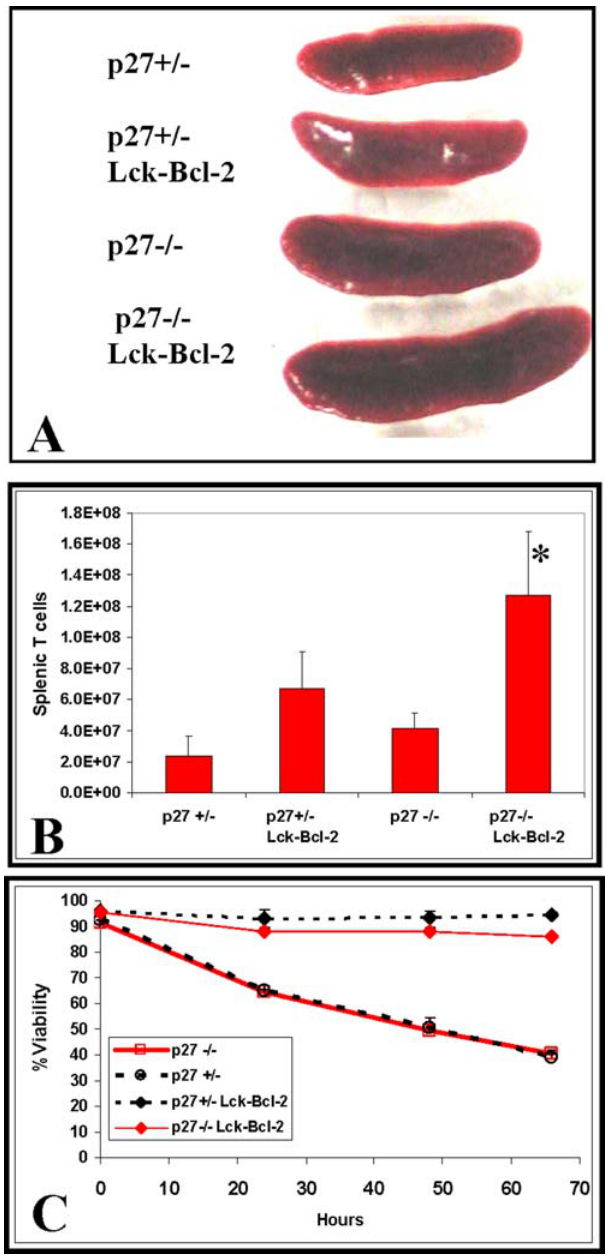
Figure 1. Lymphoid hyperplasia in p27 2 / 2 Lck-Bcl-2 mice. Spleens were dissected and T cells isolated from p27 2 / 2 Lck-Bcl-2 transgenic mice and analyzed for viability and total splenic T cells as described in the Materials and Methods. Control groups included p27 2 / 2 , p27 + / 2 , and p27 + / 2 Lck-Bcl-2 mice. A ) Representative images of spleens from mice of the indicated genotypes. B ) Total splenic T cells were determined by staining with an anti-CD3 antibody as described in the Materials and Methods. The Mean 6 SD of at least three mice is shown for the genotypes indicated. * P value , 0.01 compared to all three other groups. C ) Purified T cells from mice of the indicated genotypes were prepared and cultured as described in the Materials and Methods. Viability was determined over time by using the Guava Flow cytometer and Viacount reagent. The mean 6 SD for duplicate samples are